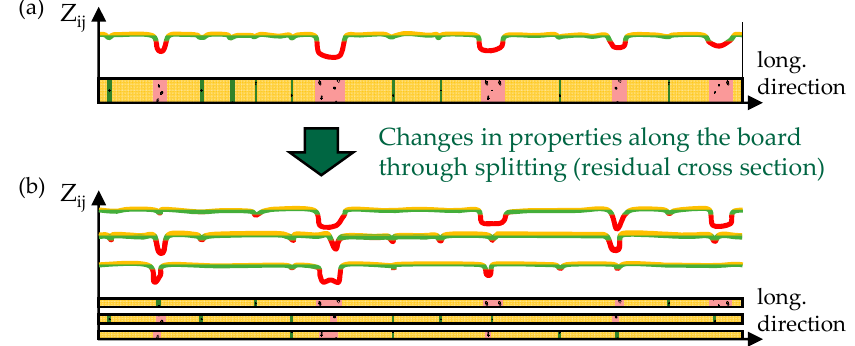
Figure 1. Qualitative changes in properties (e.g., the tensile strength) along a single board strength graded in full cross-section ( a ) and when split lengthwise into three equal pieces ( b ).